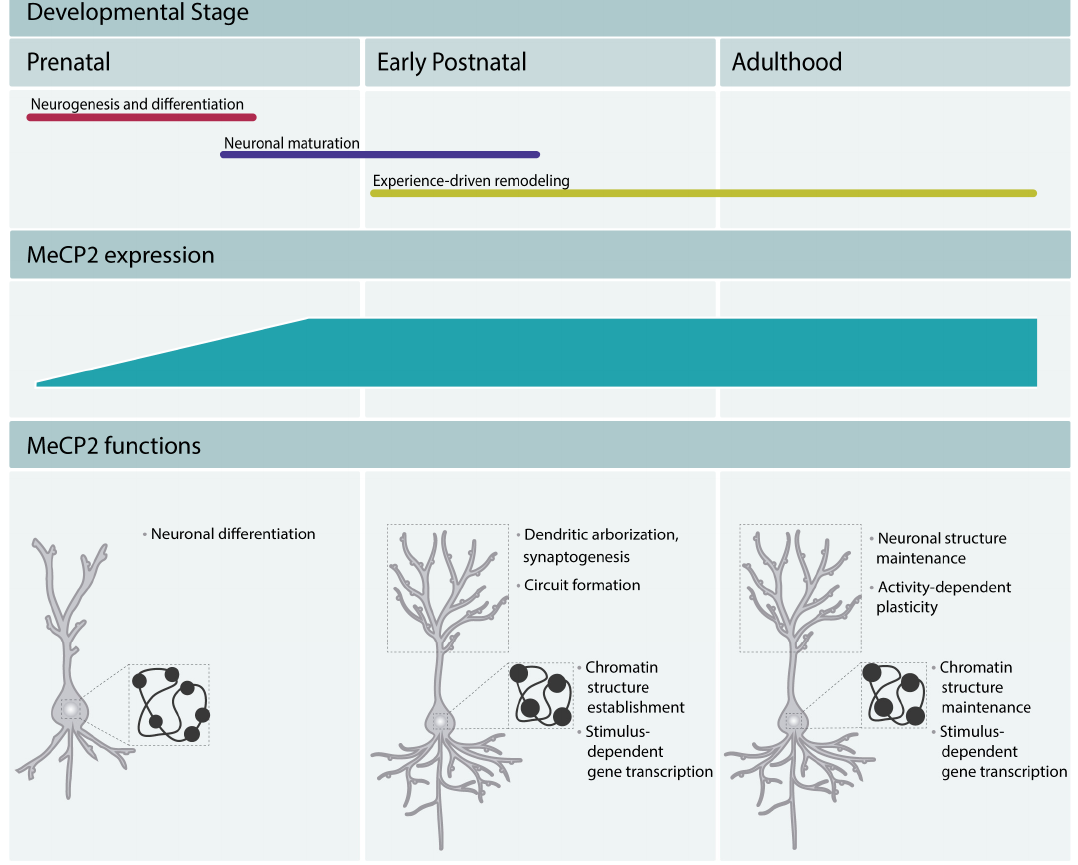
Figure 2. MeCP2 regulates brain development and maintains the function of mature neurons throughout adulthood. MeCP2 regulates neuronal differentiation in early embryonic development, neuronal maturation, and circuit formation. MeCP2 promotes chromocenter clustering during differentiation and maturation, and thus participates in the establishment of the typical chromatin structure of mature neurons (mature neurons present fewer and denser chromocenters, represented in the Figure as black dots in the nucleus). In adulthood, MeCP2 is a critical factor in the maintenance of the neuronal function. It maintains the chromatin structure and regulates the neuronal transcriptomic profile. Moreover, it appears to maintain a permissive state for stimulus-dependent gene transcription and regulate cognitive function.